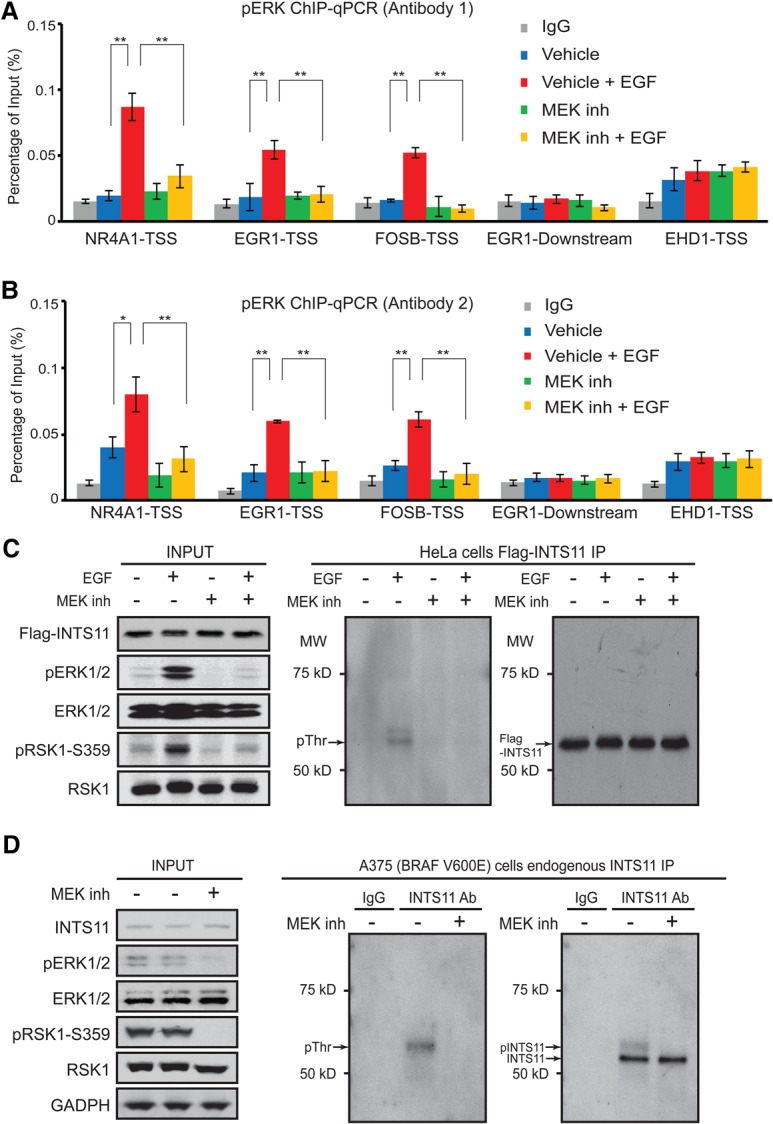
Integrator is phosphorylated following MAPK induction, and phoshpho-ERK1/2 is recruited to EGF-responsive genes upon pathway activation. (A,B) Phospho-ERK1/2 ChIP-qPCR (ChIP combined with qPCR) with antibody-1 (Cell Signaling Technology, no. 4370) and antibody-2 (Invitrogen, no. 700012). The cells were collected before and after 20 min of EGF induction with or without the presence of MEK inhibitor (PD0325901). After ChIP, qPCR was performed with primers located in the TSS region of the NR4A1, EGR1, and FOSB genes. The primer pairs located in the TSS region of the EHD1 gene and ∼3 kb downstream from the transcription end site (TES) of the EGR1 gene were used as negative controls. The average from at least three independent experiments is shown. (*) P < 0.05; (**) P < 0.01, t-test. (C,D) Western blots of immunoprecipitation for exogenous expression of Flag-INTS11 in HeLa cells (C) and endogenous INTS11 in A375 (BRAF_V600E) cells (D). Phosphorylated INTS11 protein was detected by specific antibody against phosphothreonine (Cell Signaling, no. 9381).